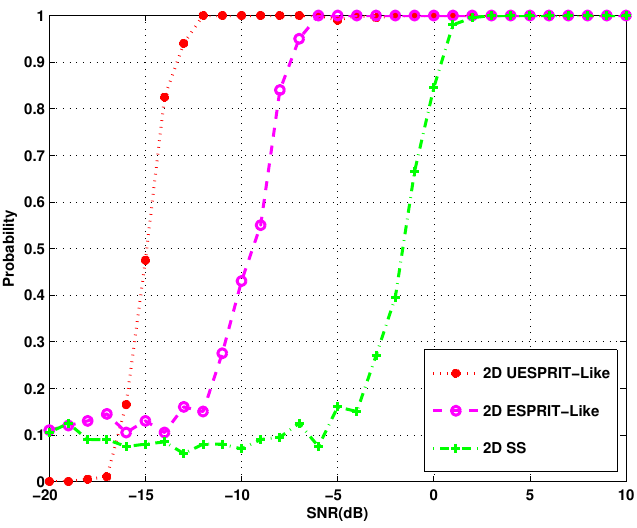
Figure 3. Probability of the DOA identification versus input signal to noise ratio